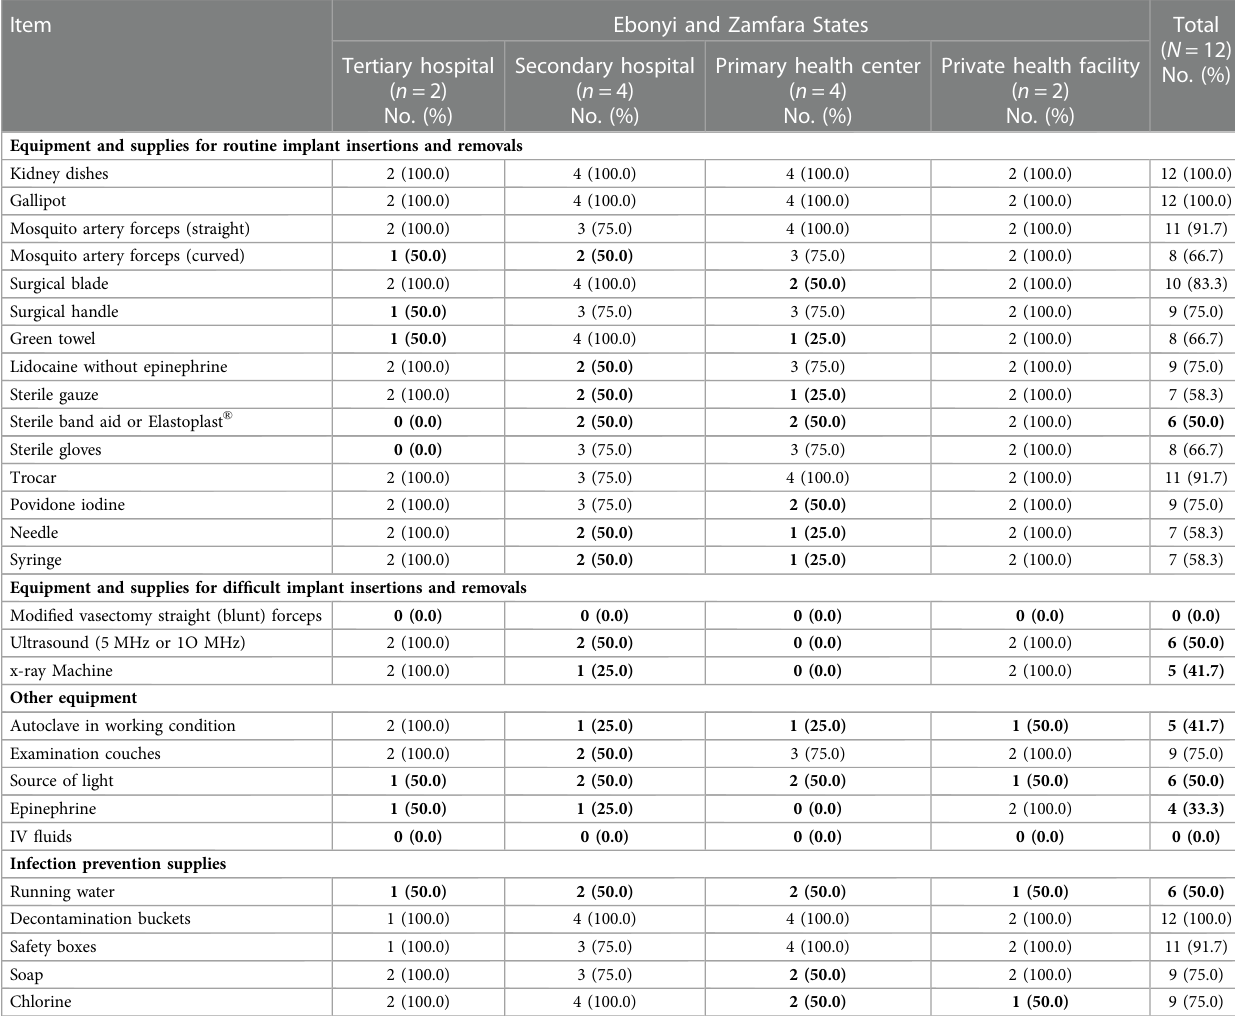
Bold text indicates items that 50% or fewer facilities reported